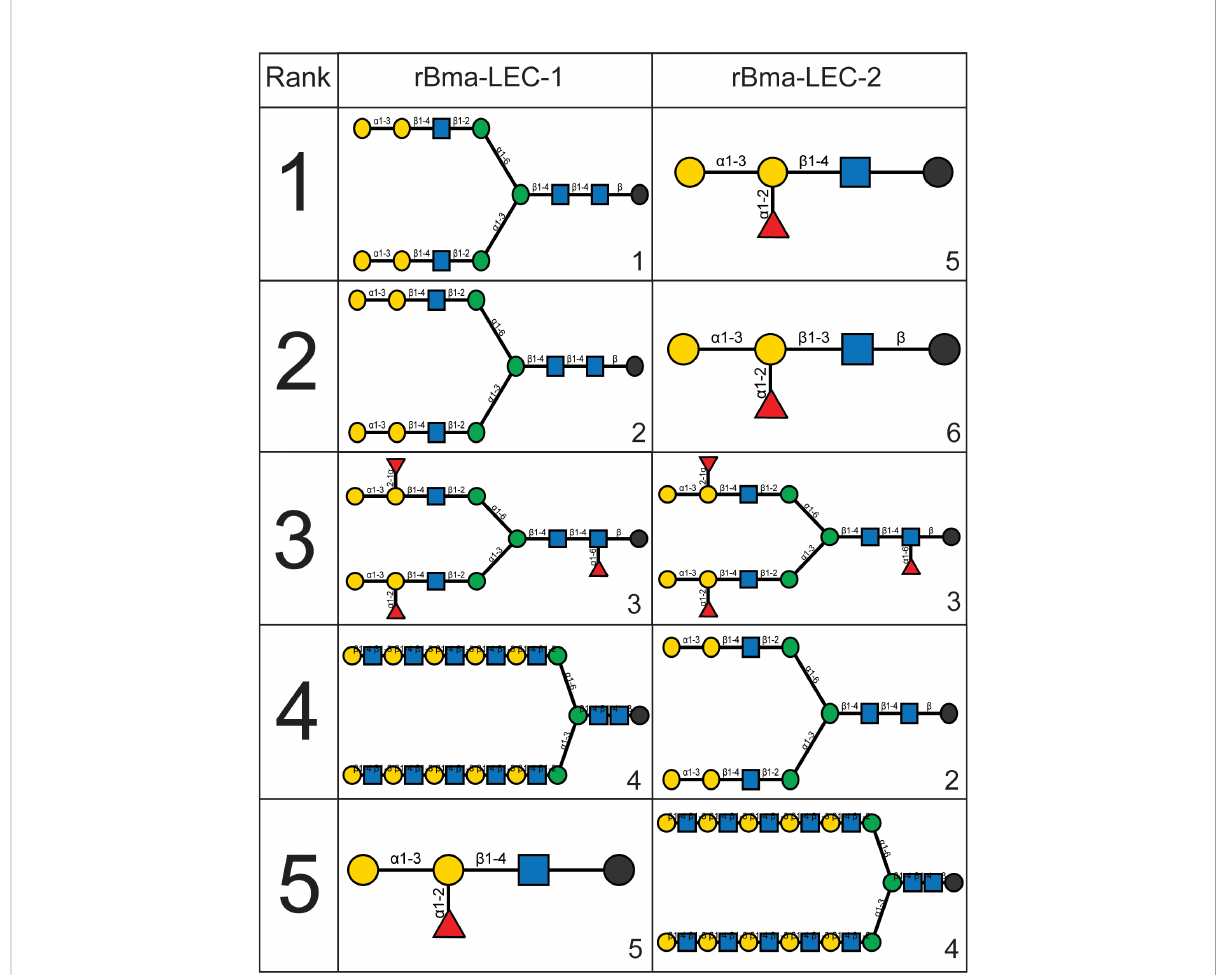
FIGURE 5 Structures of rBma-LEC-1/LEC-2 highest af fi nity glycans. The binding af fi nities of rBma-LEC-1 and rBma-LEC-2 were investigated with a glycan binding array. rBma-LEC-1 had high af fi nity for alpha-galactose on a biantennary N-glycan, for blood group B on a biantennary N-glycan, and for blood group B on multiple O-glycan and N-glycan motifs. rBma-LEC-2 had high af fi nity for blood group B, for blood group B on biantennary N-glycans, for alpha-galactose on biantennary N-glycans, and for various O-glycan and N-glycan motifs. This table shows the structures of the top fi ve highest binding glycans. 1: Gala1-3Galb1-4GlcNAcb1-2Mana1-6(Gala1-3Galb1-4GlcNAcb1-2Mana1-3)Manb1- 4GlcNAcb1-4GlcNAcb-GENR, 2: Gala1-3Galb1-4GlcNAcb1-2Mana1-6(Gala1-3Galb1-4GlcNAcb1-2Mana1-3)Manb1-4GlcNAcb1-4GlcNAc- KVANKT, 3: Gala1-3(Fuca1-2)Galb1-4GlcNAcb1-2Mana1-6(Gala1-3(Fuca1-2)Galb1-4GlcNAcb1-2Mana1-3)Manb1-4GlcNAcb1-4(Fuca1-6) GlcNAcb-NST, 4: Galb1-4GlcNAcb1-3Galb1-4GlcNAcb1-3Galb1-4GlcNAcb1-3Galb1-4GlcNAcb1-3Galb1-4GlcNAcb1-2Mana1-6(Galb1- 4GlcNAcb1-3Galb1-4GlcNAcb1-3Galb1-4GlcNAcb1-3Galb1-4GlcNAcb1-3Galb1-4GlcNAcb1-2Mana1-3)Manb1-4GlcNAcb1-4GlcNAcb-VANK, 5: Gala1-3(Fuca1-2)Galb1-4GlcNAc-CH2CH2NH2, 6: Gala1-3(Fuca1-2)Galb1-3GlcNAcb-